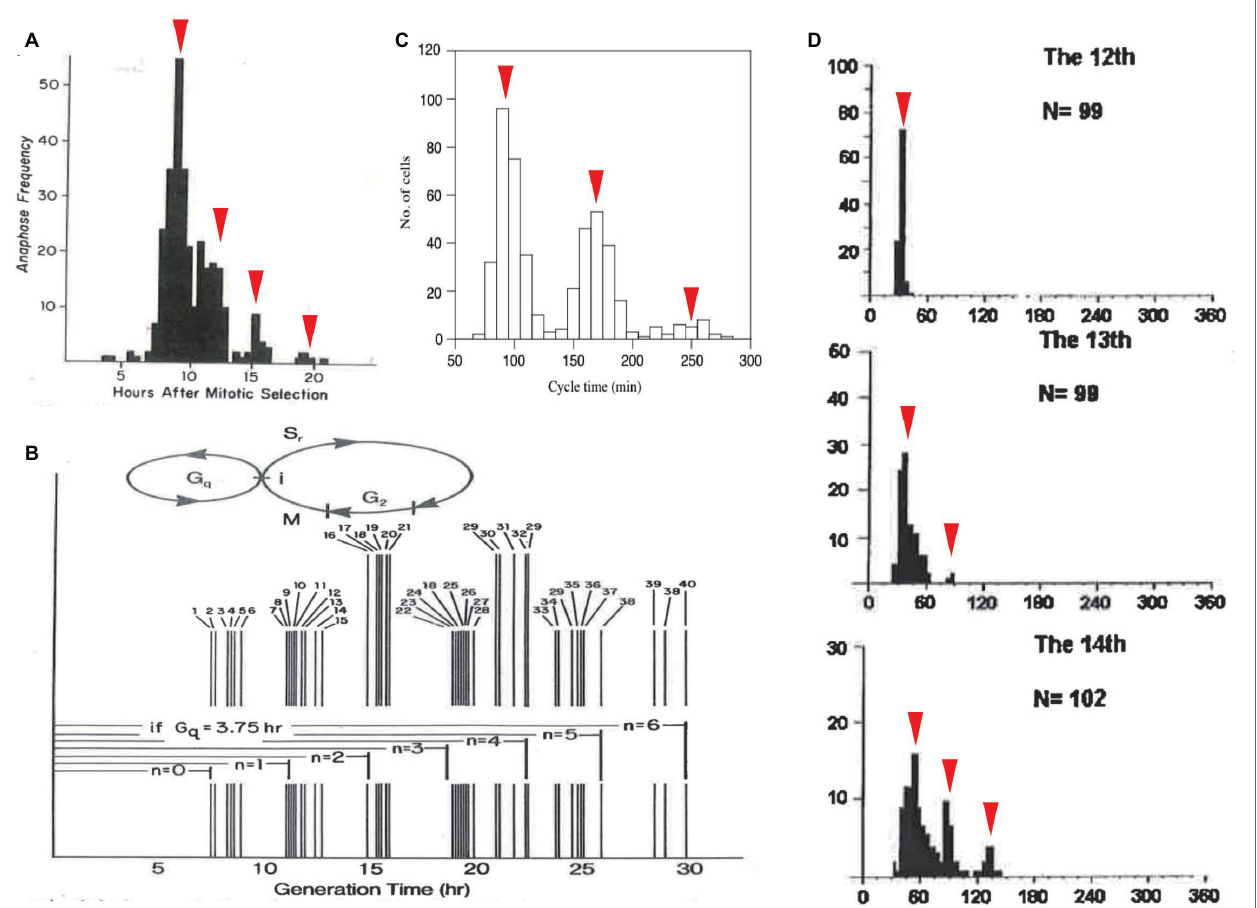
FIGURE 3 | Quantized control of the CDC in various organisms. Quantized cell-cycle duration in mammalian cell lines (A,B) , in fission yeast mutant cells (C) , and in Xenopus embryonic cells (D) . Cell-cycle duration was elongated at an interval of 3–4 h in mammalian cells (A,B) and 60–70 min in fission yeast cells (C) . Cell-cycle duration at 13th, 14th, and 15th cleavage stages after the first cell cleavage was elongated at an interval of 30 min in Xenopus embryos (D) . Panels (A,B) are reused from (Klevecz, 1976), whose copyright is in the public domain. Panel (C) is reproduced with permission from Figure 6 in Sveiczer et al. (1996). Copyright permission of Panel (A) (Wang et al., 2000) was obtained from John Wiley & Sons, Inc. Arrowheads are added as a